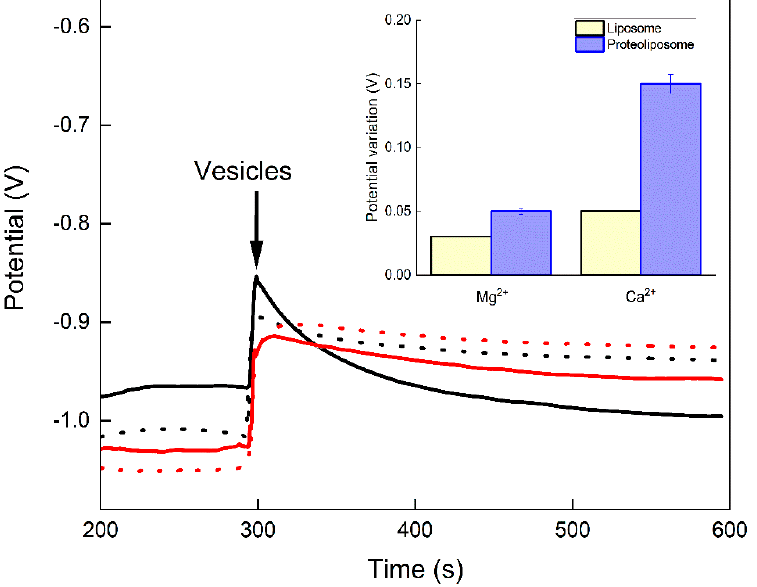
Figure 4. Potential (V) versus time (s) curve recorded with the BNCD microelectrode in the presence of either Mg 2+ or Ca 2+ ions in deionized water. After the first equilibration, 10 μ L of liposomes (0.6 mg/mL of total lipid) (dot lines) or proteoliposomes (0.6 mg/mL of total lipid containing 14 μ g/mL of AnxA5) (continuous lines) were added at 300 s to the microelectrode compartment. Black lines correspond to the potential recordings in the presence of 1 mM Ca 2+ ions and red lines to potential recordings in the presence of 1 mM Mg 2+ ions. Inset: Absolute values of the potential changes observed from 300 to 600 s, i.e., over the long-term transient after the addition of vesicles.